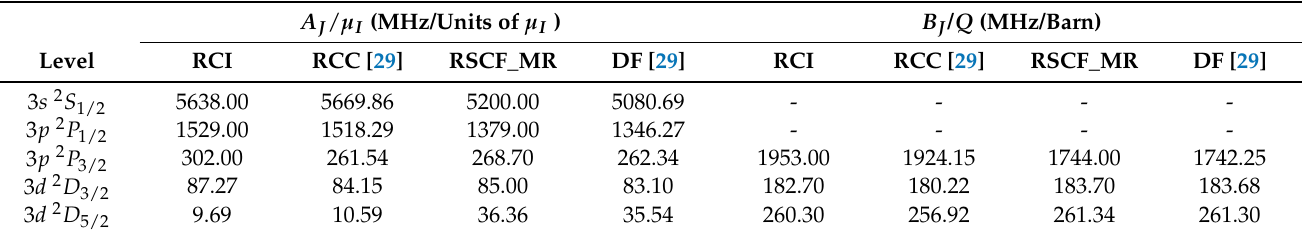
Table 7. Comparison of the present hyperfine constants A J / µ I (MHz per units of µ I ), B J / Q (MHz/barn) with the corresponding results of Dutta and Majumder [29] for Ar 7 + . A J / µ I (MHz/Units of µ I ) B J / Q